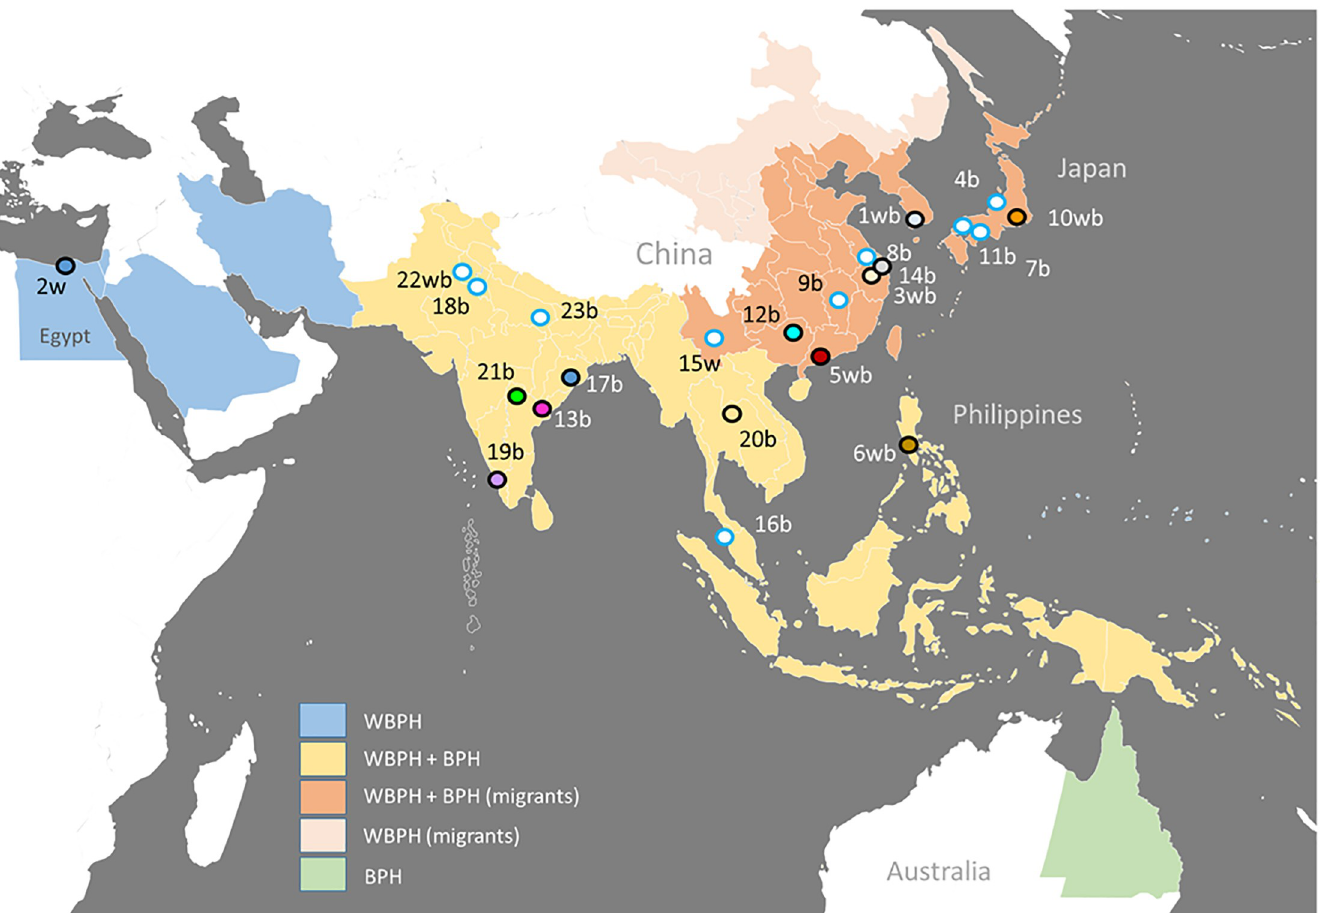
Fig 1. Approximate distribution of the whitebacked planthopper ( Sogatella furcifera : WBPH) and brown planthopper ( Nilaparvata lugens : BPH) around the Indian and Pacific Oceans. Distributions are based on national or provincial (Australia and China) records. The locations of population sources for planthopper colonies that have been used in climate and temperature studies are indicated. Open points with blue outlines were not used in our species level analyses (Section 2.3); colored points correspond with colored symbols used in the present paper. Numbers are regions where planthopper populations have been assessed for their responses to temperature. Some regions include multiple published studies. 1 = South Korea [35,36];2 = Kafr-el-Sheikh, Egypt [37]; 3 = Hangzhou, China [33,38–40];4 = Niigata, Japan [41]; 5 = Guangzhou, China [42]; 6 = Laguna, Philippines [43,44];7 = Kagawa, Japan; 8 = Jiangsu, China; 9 = Jiangxi, China; 10 = central Japan [34]; 11 = Hiroshima, Japan; 12 = Guangxi, China [45]; 13 = Godavari, India [46,47];14 = Shanghai, China; 15 = Yunnan, China; 16 = Pulau Pinang, Malaysia [10,11]; 17 = Odisha, India [48]; 18 = New Delhi and Haryana, India [19,49];19 = Tamil Nadu, India [50]; 20 = Khin Kaen, Thailand [51]; 21 = Rajendranagar, India